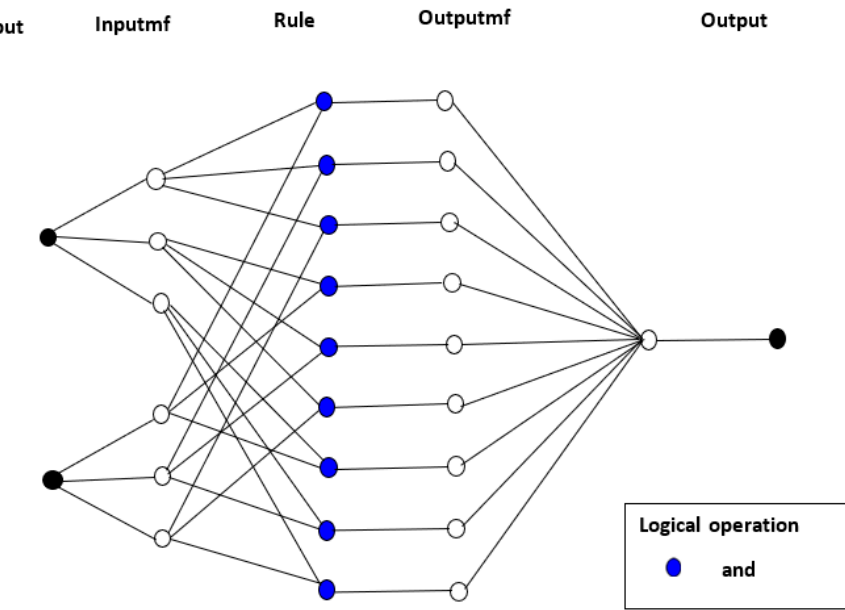
Figure 5. ANFIS model structure.